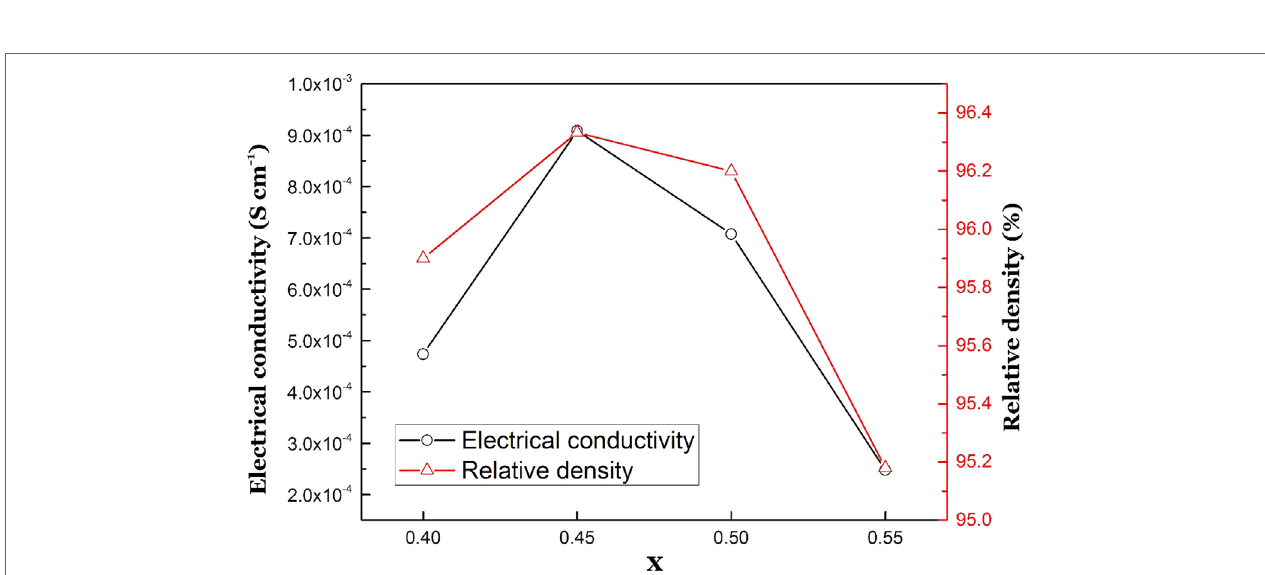
FigUre 11 | Total electrical conductivity at 25°c and relative density of li 1 + x al x ge 0.3 Ti 1.8 − x (PO 4 ) 3 as a function of x .